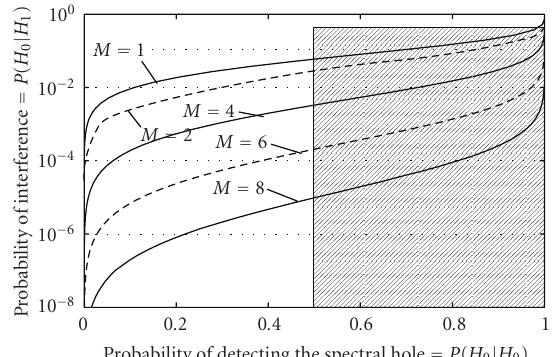
Figure 6: Narrowband transmission against interference probabil- ity characteristics in LSC, with M = [1,2,4,6,8] collaborating CR. The shaded region highlights the convexity domain of